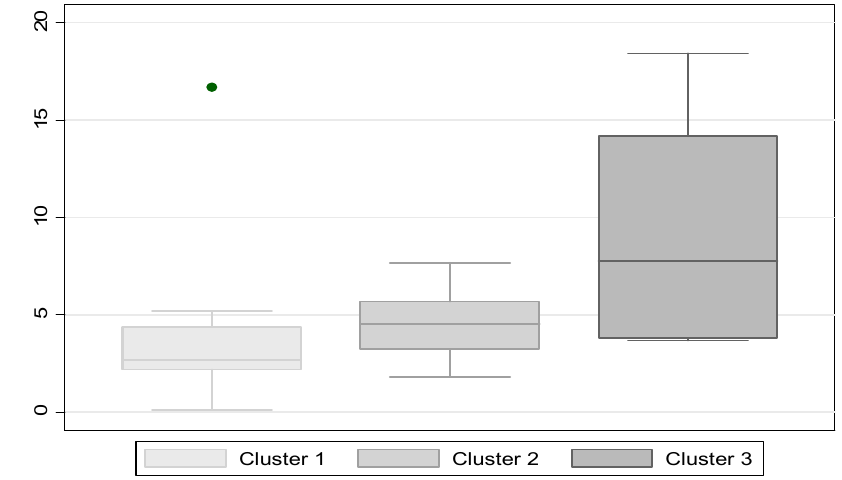
Figure 1. Partial Productivity of land in the three clusters across European countries; Source: [34] and own calculations .